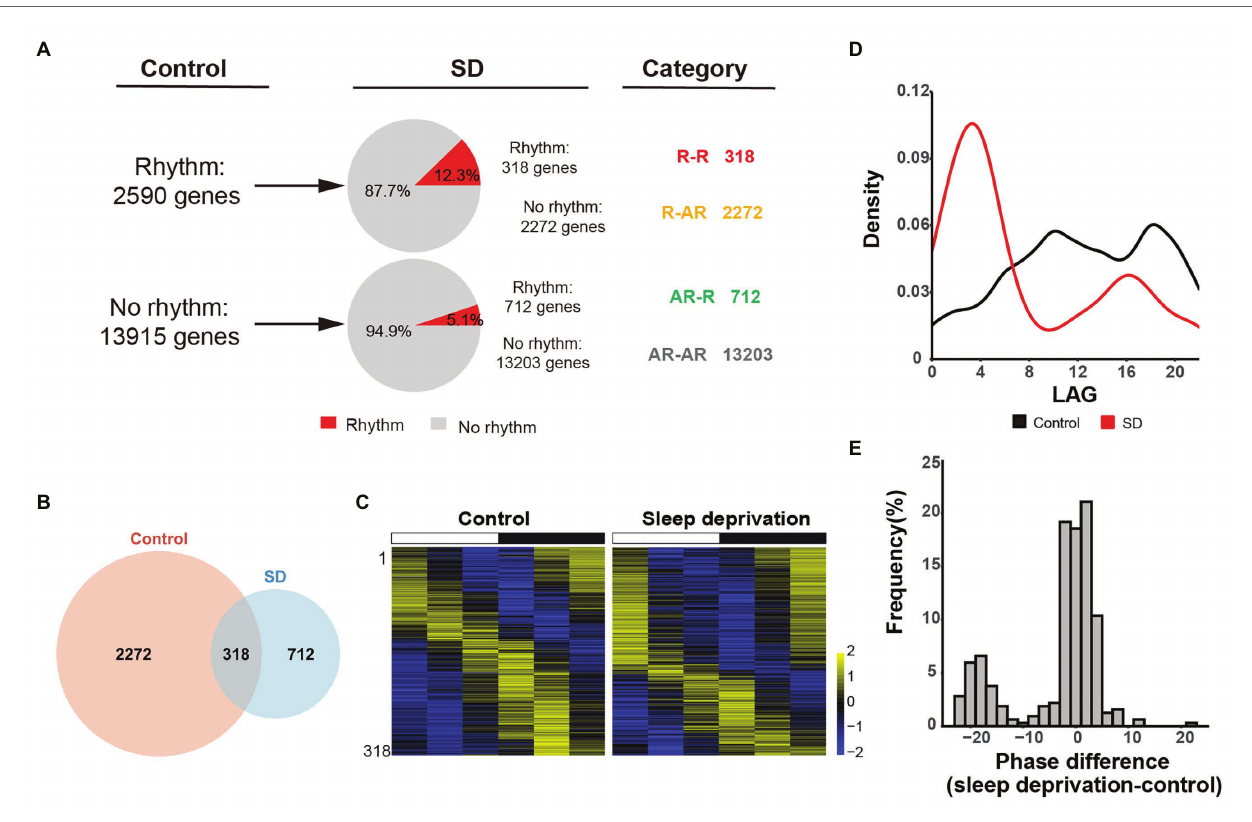
FIGURE 1 | Sleep deprivation alters the circadian gene transcription in lung. (A) Quantification of the number of genes that are rhythmically transcribed in the mouse lung. The rhythmic signals are detected by JTK_CYCLE from time-series datasets. Four categories of rhythmically expressed genes were determined by comparing the control and sleep deprivation conditions: rhythmic genes in both conditions (R-R), rhythmic genes only in control condition (R-AR), rhythmic genes only in SD condition (AR-R), and arrhythmic genes in both conditions (AR-AR). (B) Area-proportional Venn diagram comparing rhythmic genes identified in the two conditions. (C) Heatmap representation of R-R category for the 318 genes that are rhythmically transcribed in the mouse lung. Classification is based on the phase of mRNA oscillations, and each lane corresponds to one gene. High expression is displayed in yellow ( z -score > 1) while low expression in blue ( z -score < 1). (D) Phase distribution for 3,620 rhythmic genes in two conditions. (E) Distribution of the difference between the phase of cycling gene expression in control and SD for the 318 R-R